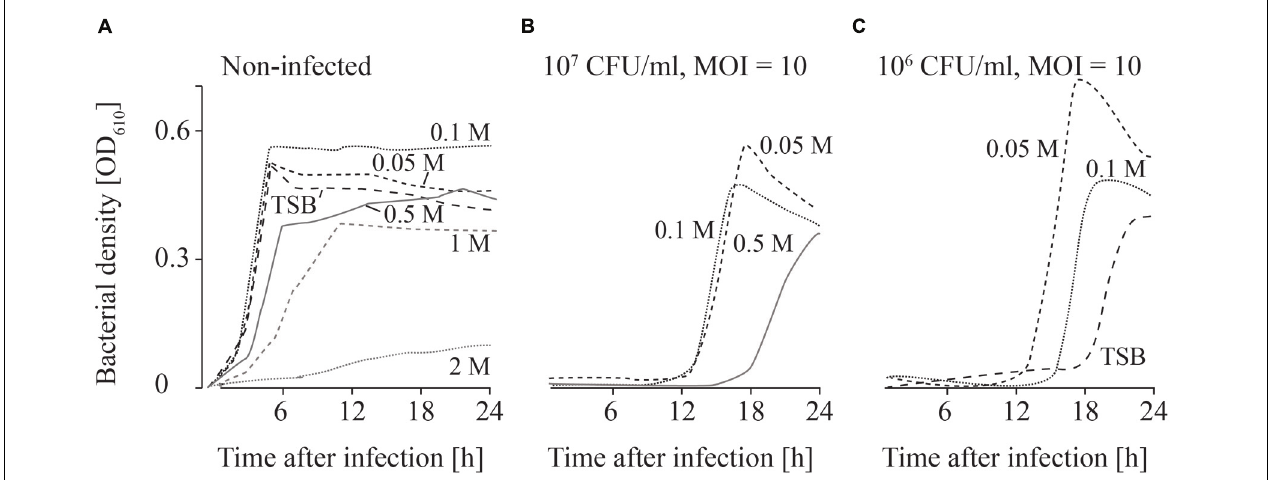
FIGURE 4 | Growth curves of uninfected (A) and infected (B,C; MOI = 10) L. monocytogenes in TSB and NaCl containing TSB media. Bacteria concentrations at the beginning of the infections were 10 7 CFU/ml (A,B) and 10 6 CFU/ml (C) . All NaCl concentrations (0–2 M) were tested. For the sake of clarity only the curves of growing bacteria were demonstrated while the others on base line level were not depicted. Moreover, one of four independent experiments is representatively shown.